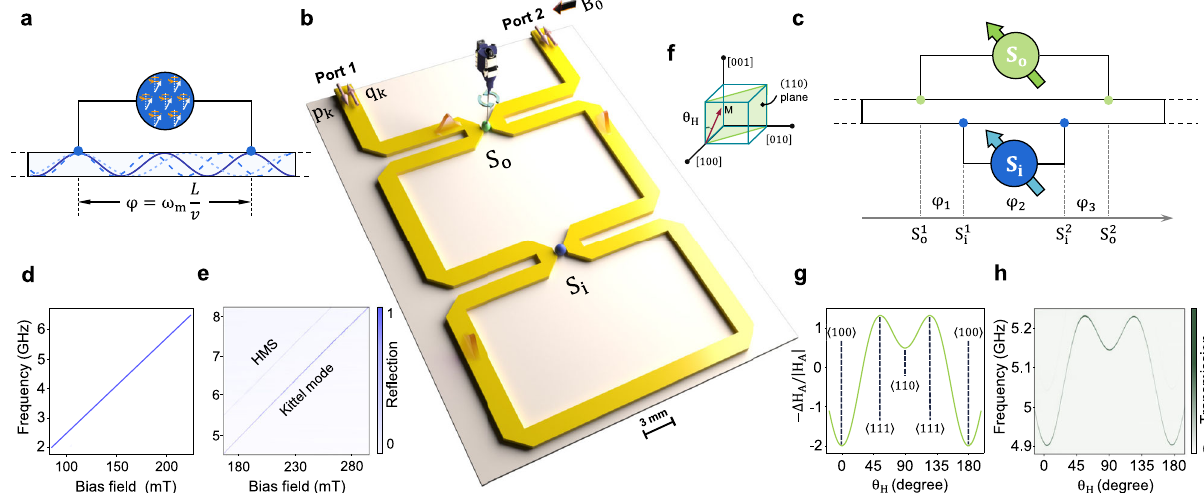
Fig.1|Implementationofsinglegiantspinensembleandnestedtwogiantspin ensembles.a SchematicofasingleGSE,whereasmallYIGspherecoupleswiththe waveguide at two well-separated locations. The phase φ induced by the propaga- tionofthemicrowavephotonsbetweenthetwocouplingpointscanbeadjustedby tuning the resonance frequency ω m of the magnon mode. b Schematic of the experimental device of the nested two GSEs, where the inner YIG sphere (blue) is fi xed on the waveguide, and the outer YIG sphere (green) is glued on a cantilever which is rigidly connected to a rotating motor. These YIG spheres are magnetized byabias fi eld B 0 .TheGSEisrealizedbycouplingtheYIGspheretothemeandering waveguide (yellow) and sending a probe signal ^ p k ð ^ q k Þ (red arrow) into the wave- guide,wherethemicrowavesignal(pink)caninteractwiththespinensemblemore thanonce,yieldinganeffectivelygiantsizeofthespinensemble. c Thetopologyof